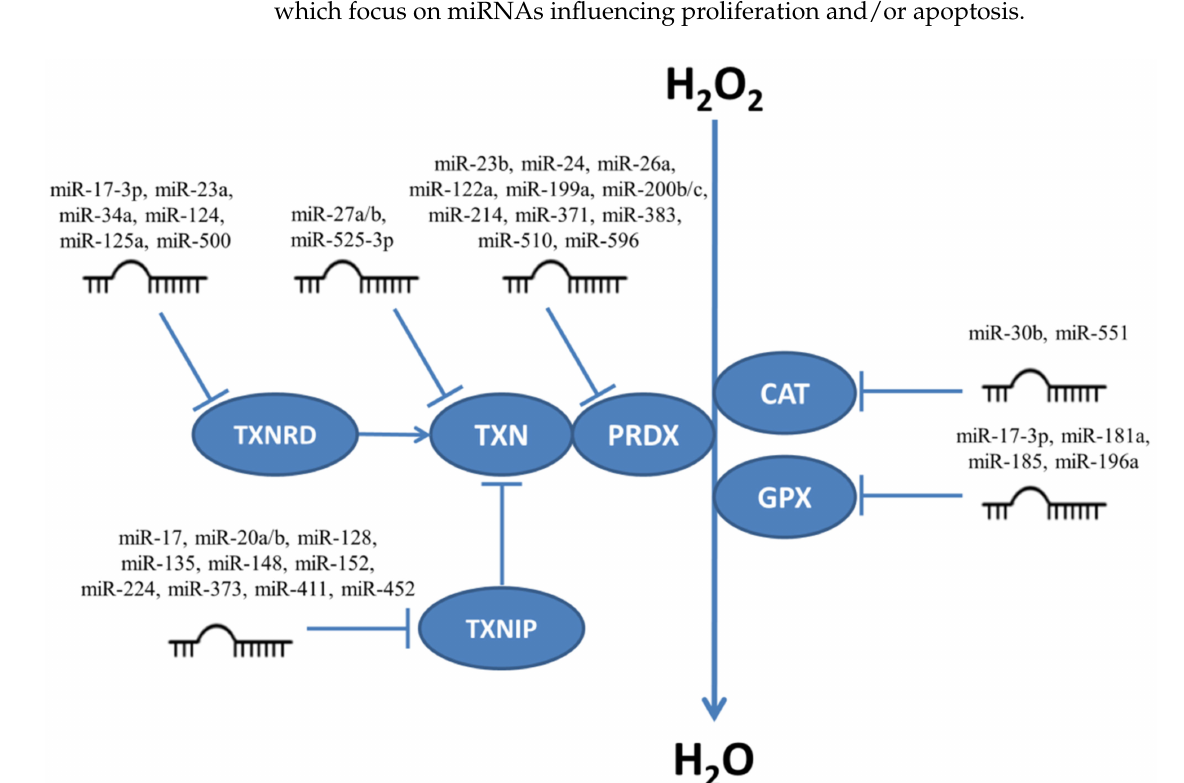
Figure 3. MiRNAs targeting enzymes responsible for neutralizing H 2 O 2 . CAT, catalase; GPX, glutathione peroxidase; PRDX, peroxiredoxin; TXN, thioredoxin; TXNRD, thioredoxin reductase; TXNIP, thioredoxin interacting